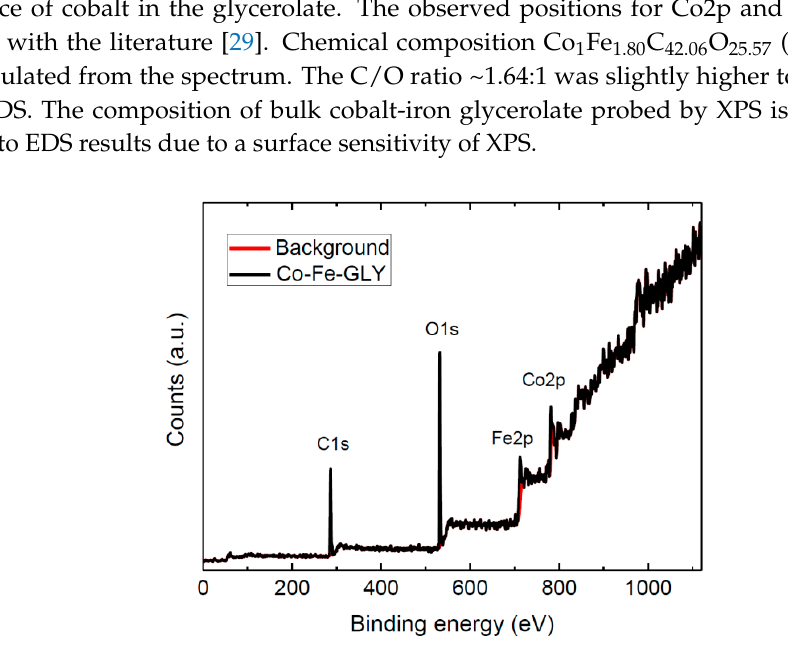
Figure 4. XPS survey spectrum of Co-Fe-GLY.